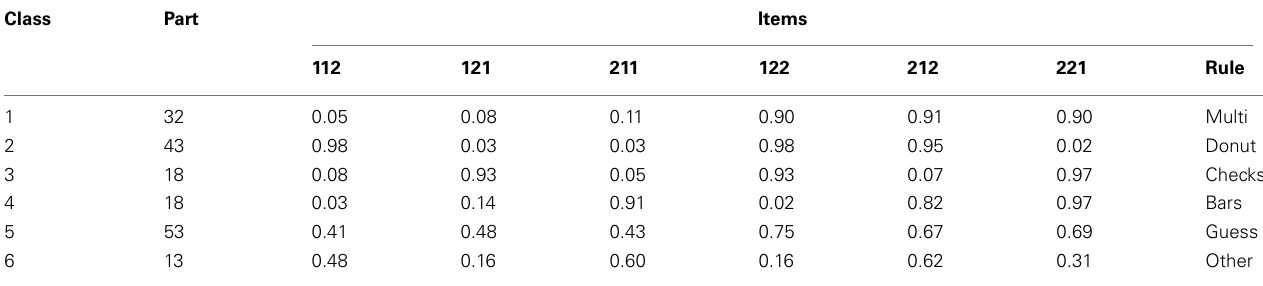
Table 3 | Parameter estimates for latent class model with six classes.